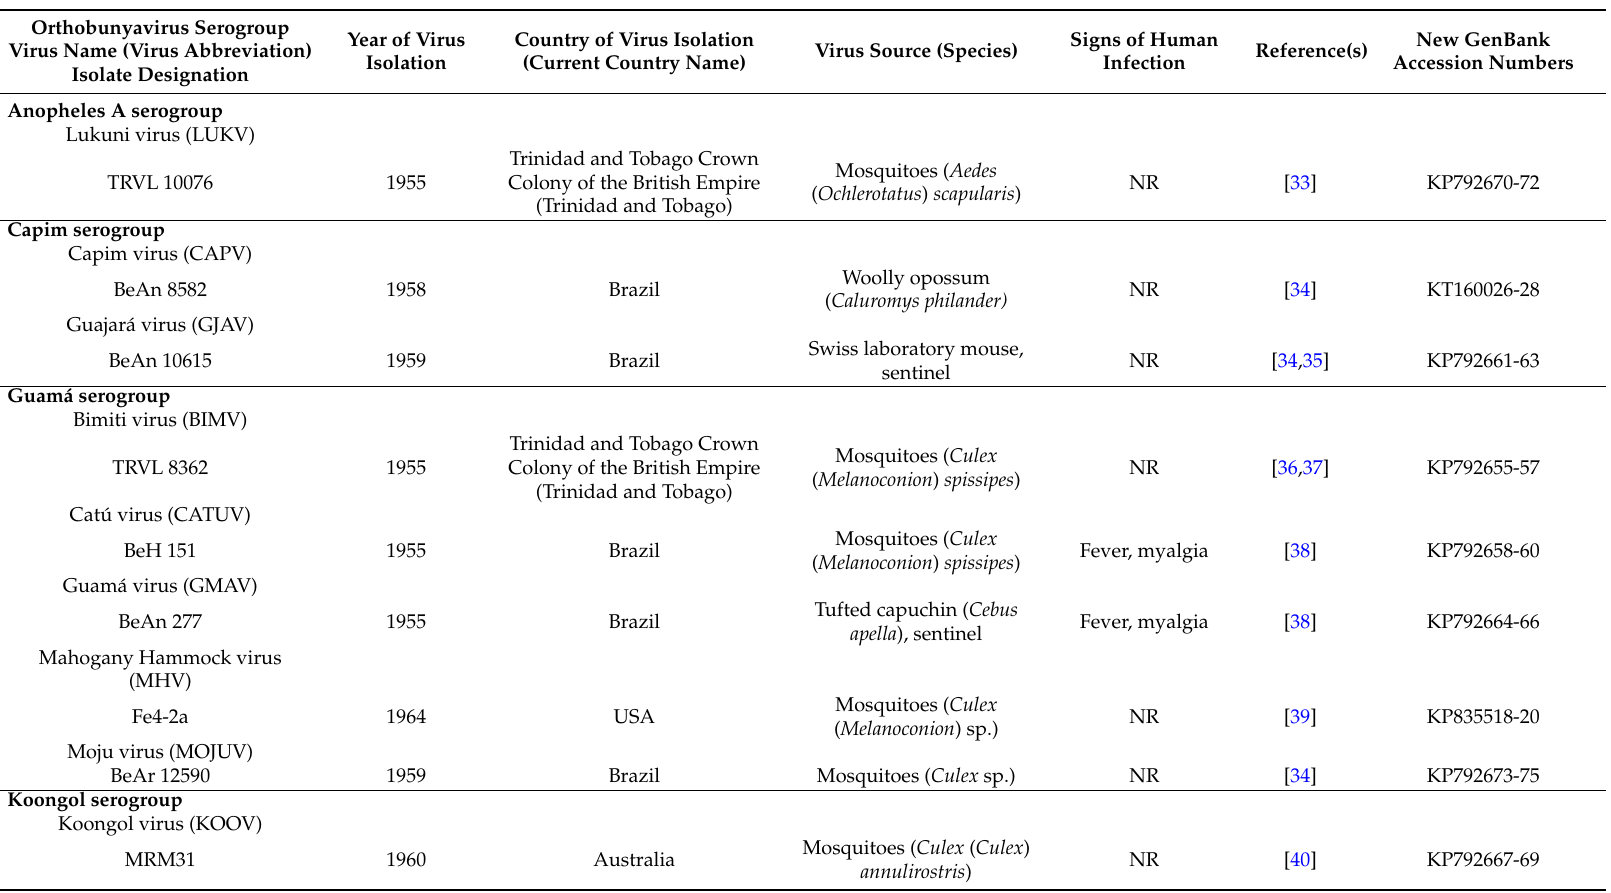
Table 1. Newly sequenced orthobunyaviruses (this